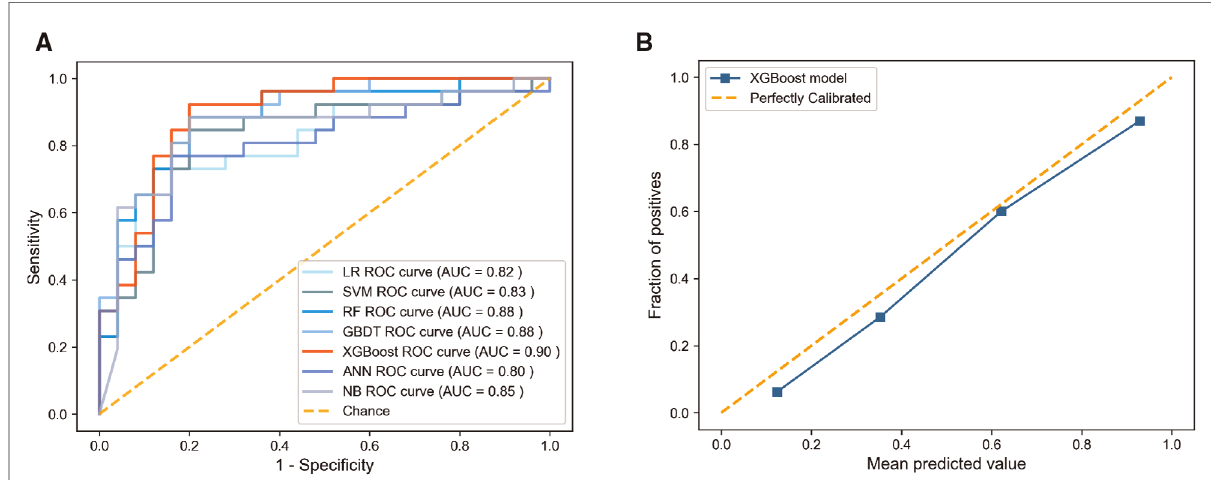
FIGURE 2 Discrimination and calibration performance of models. ( A ) ROC curves for the LR, SVM, RF, GBDT, XGBoost, ANN, and BN models in predicting pneumonia of fl ail chest, ( B ) Calibration curves for the XGBoost model. ROC, receiver operating characteristics; LR, logistic regression; SVM, support vector machine; GBDT, gradient boosting decision tree; XGBoost, extreme gradient boosting; ANN, arti fi cial neural network; NB, naive